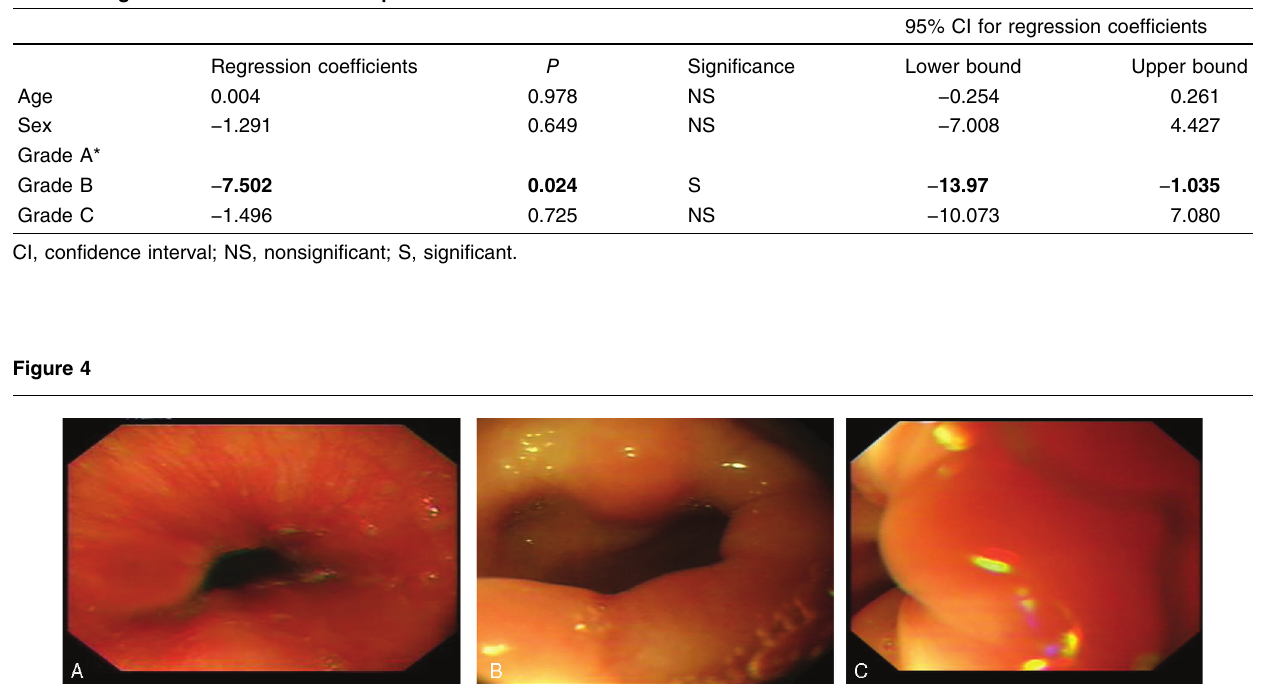
Table 5 Regression the effects of independent factors on DLCO